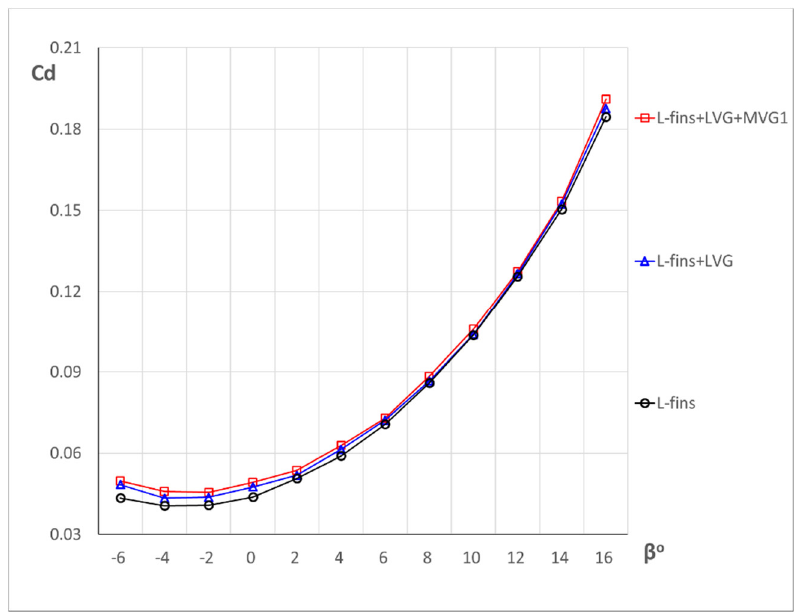
Figure 18. Yaw moment coefficient of the model equipped with combinations of L-fins, LVG, and MVG_1.